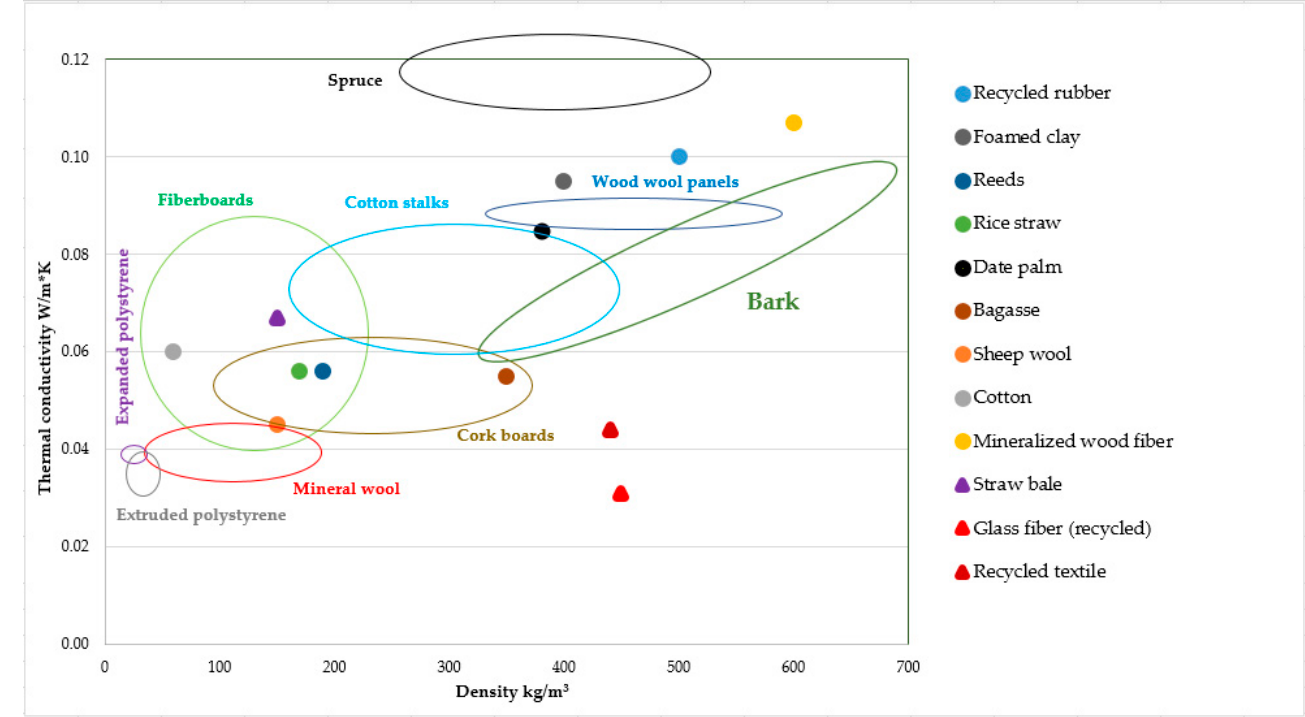
Figure 2. Thermal conductivity of thermal insulation boards .